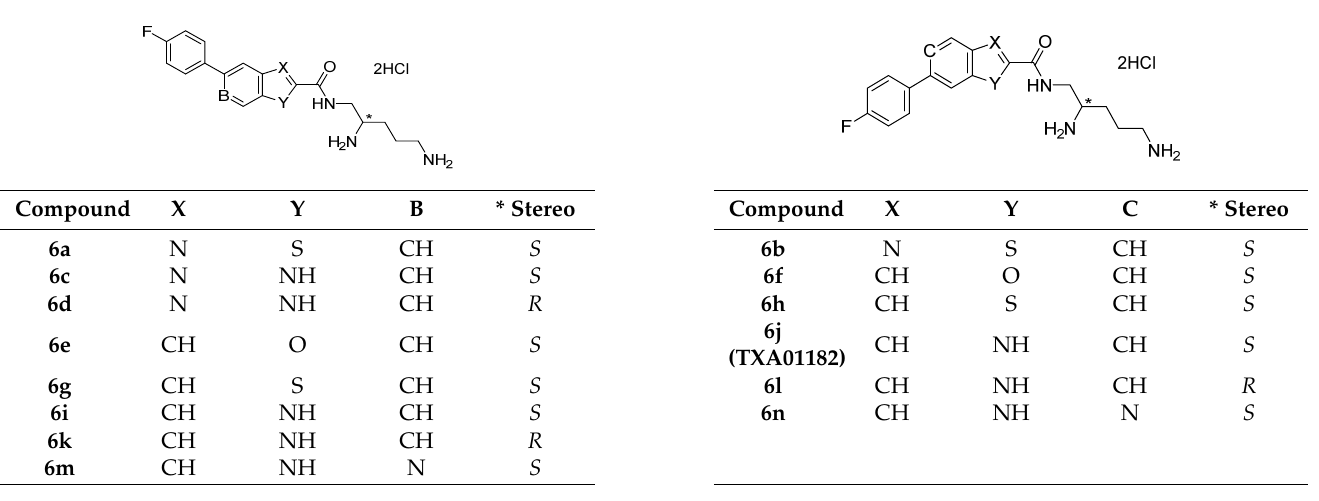
Table 1. Structures of screened compounds 6a – n .